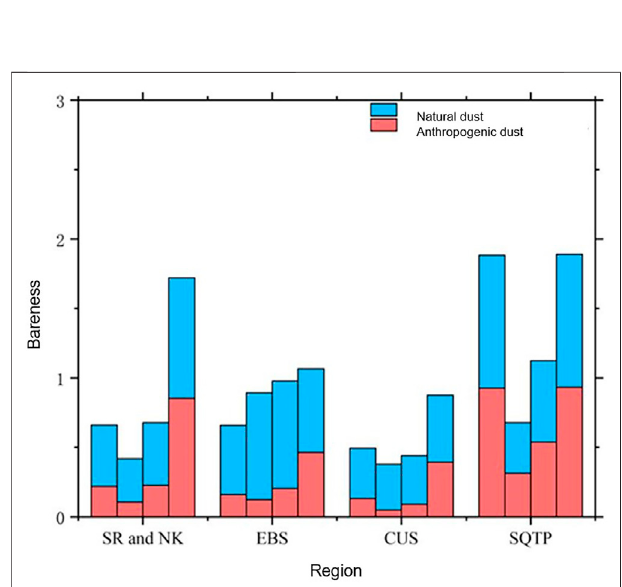
FIGURE2| Seasonalcomparison oftheADand NDsurfacebareness in typical regions during 2001 – 2018. The bars represent spring, summer, autumn, and winter from left to right. SR and NK represent southern Russia and northern Kazakhstan (45 – 54 ° N, 70 – 80 ° E); EBS represents eastern Black Sea (36 – 40 ° N, 39 – 48 ° E); CUS represents central United States (39 – 48 ° N, 100 – 120 ° W); SQTP represents the southern Tibet Plateau (30 – 32 ° N, 85 – 90 °